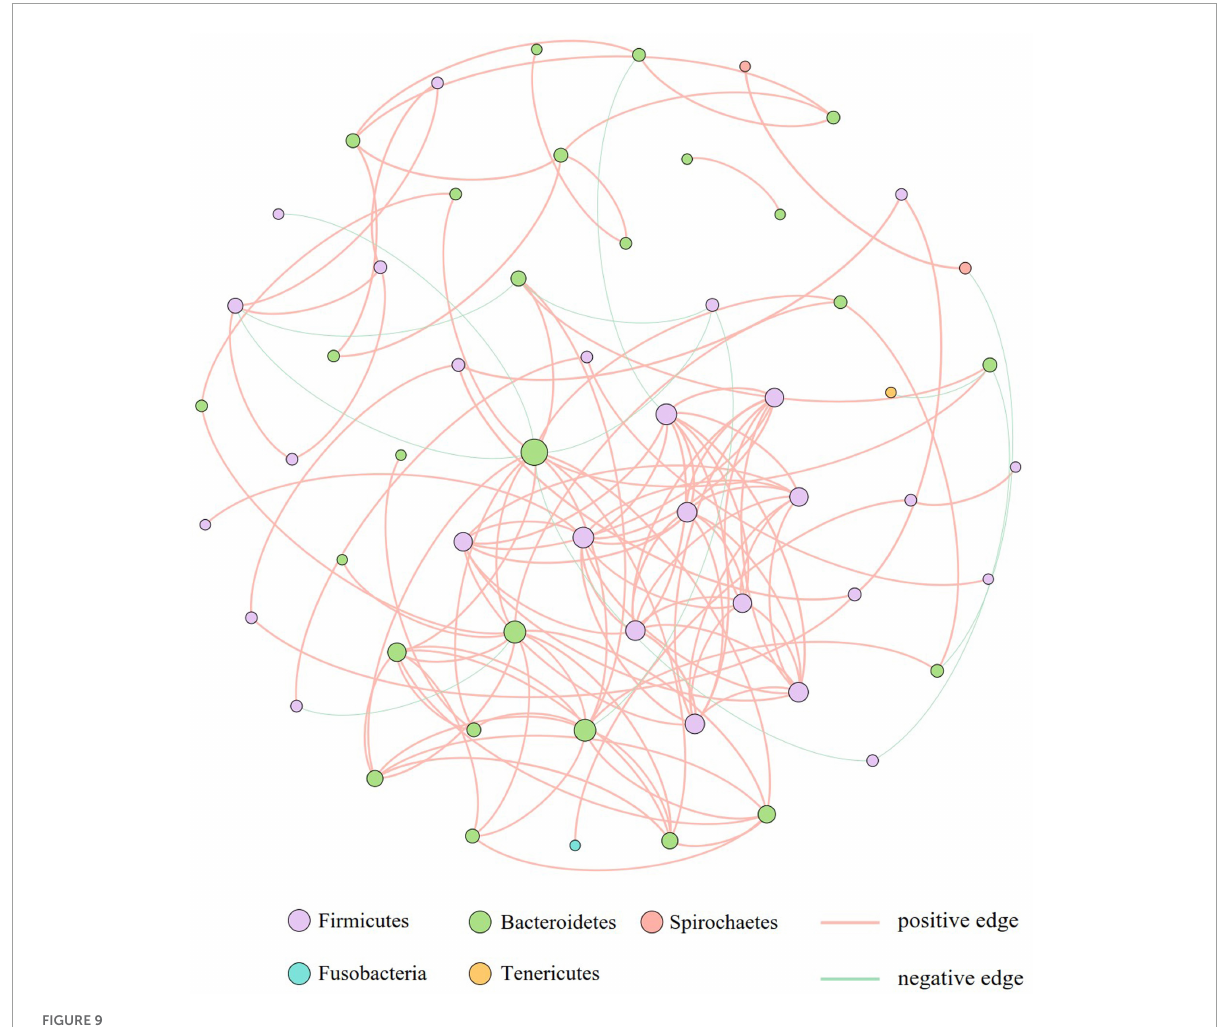
FIGURE9 Dominant OTU co-occurrence networks in Eothenomys miletus.